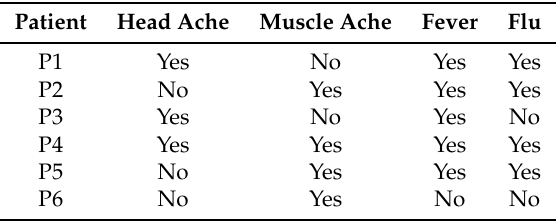
Table 1. An example of a decision